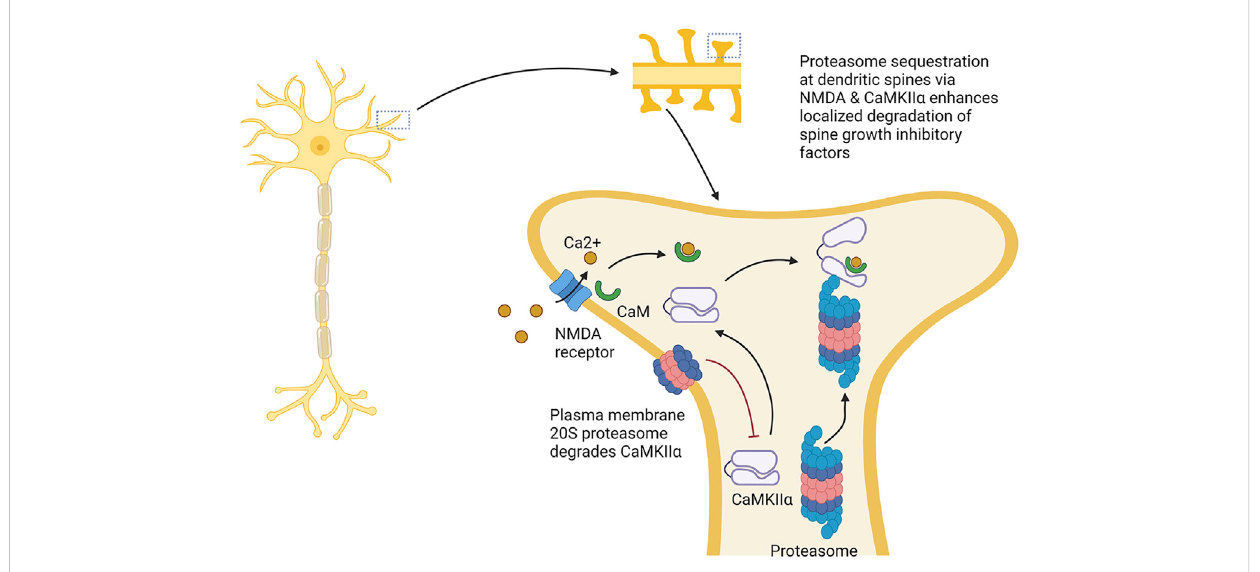
FIGURE 5 Proteasome modulation of dendriticspine growth. The proteasome plays keyroles in dendritic sprine growth. It is thought that this occurs by Ca2+ in fl ux through NMDA receptors, which localizes CaMKII α to dendritic spines, resulting in the recruitment and activation of the proteasome in dendritic spines. Activation and localization of proteasome to the dendritic spines is thought to promote dendritic spine growth by increasing degradation of factors repressing spine growth. This process is counteracted by the plasma membrane 20S proteasome, which appears to degrade CaMKII α . → is intended to denote causation. ┴ is intended to denote inhibition. Images Created with